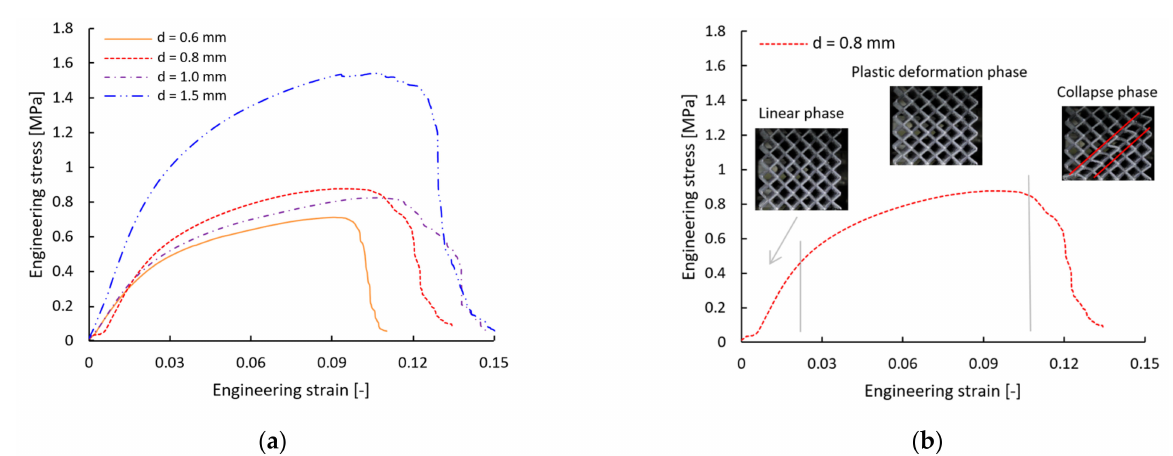
Figure 6. ( a ) Comparison of average stress–strain response of structures with different strut diameters. ( b ) Phases of structure